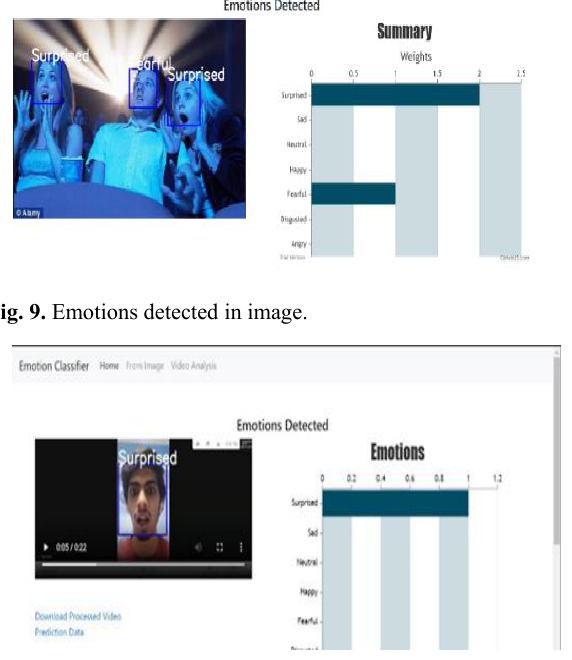
Fig. 10. Summarising reactions from live